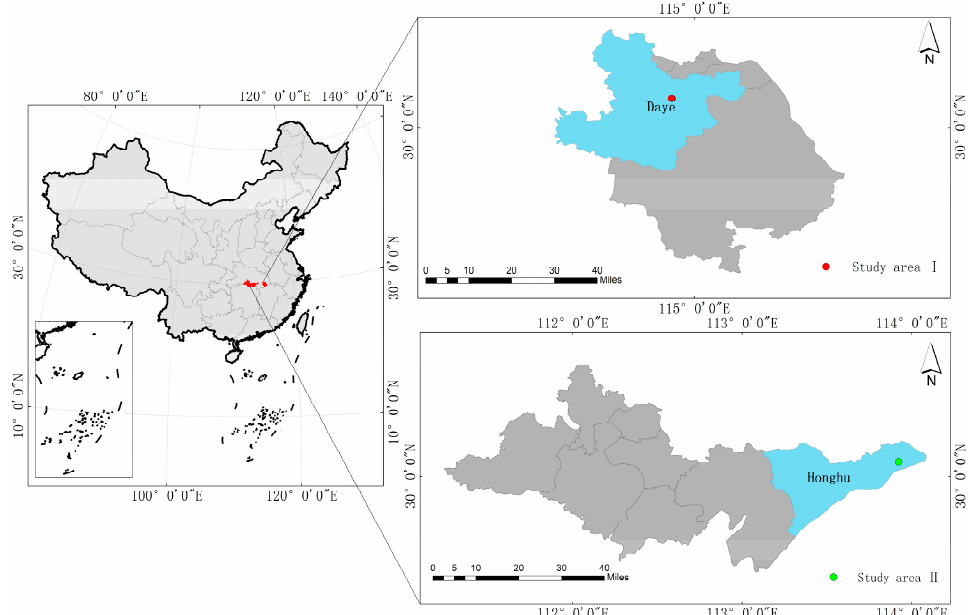
Figure 1. Study area locations. Study area I is Daye. Study area II is